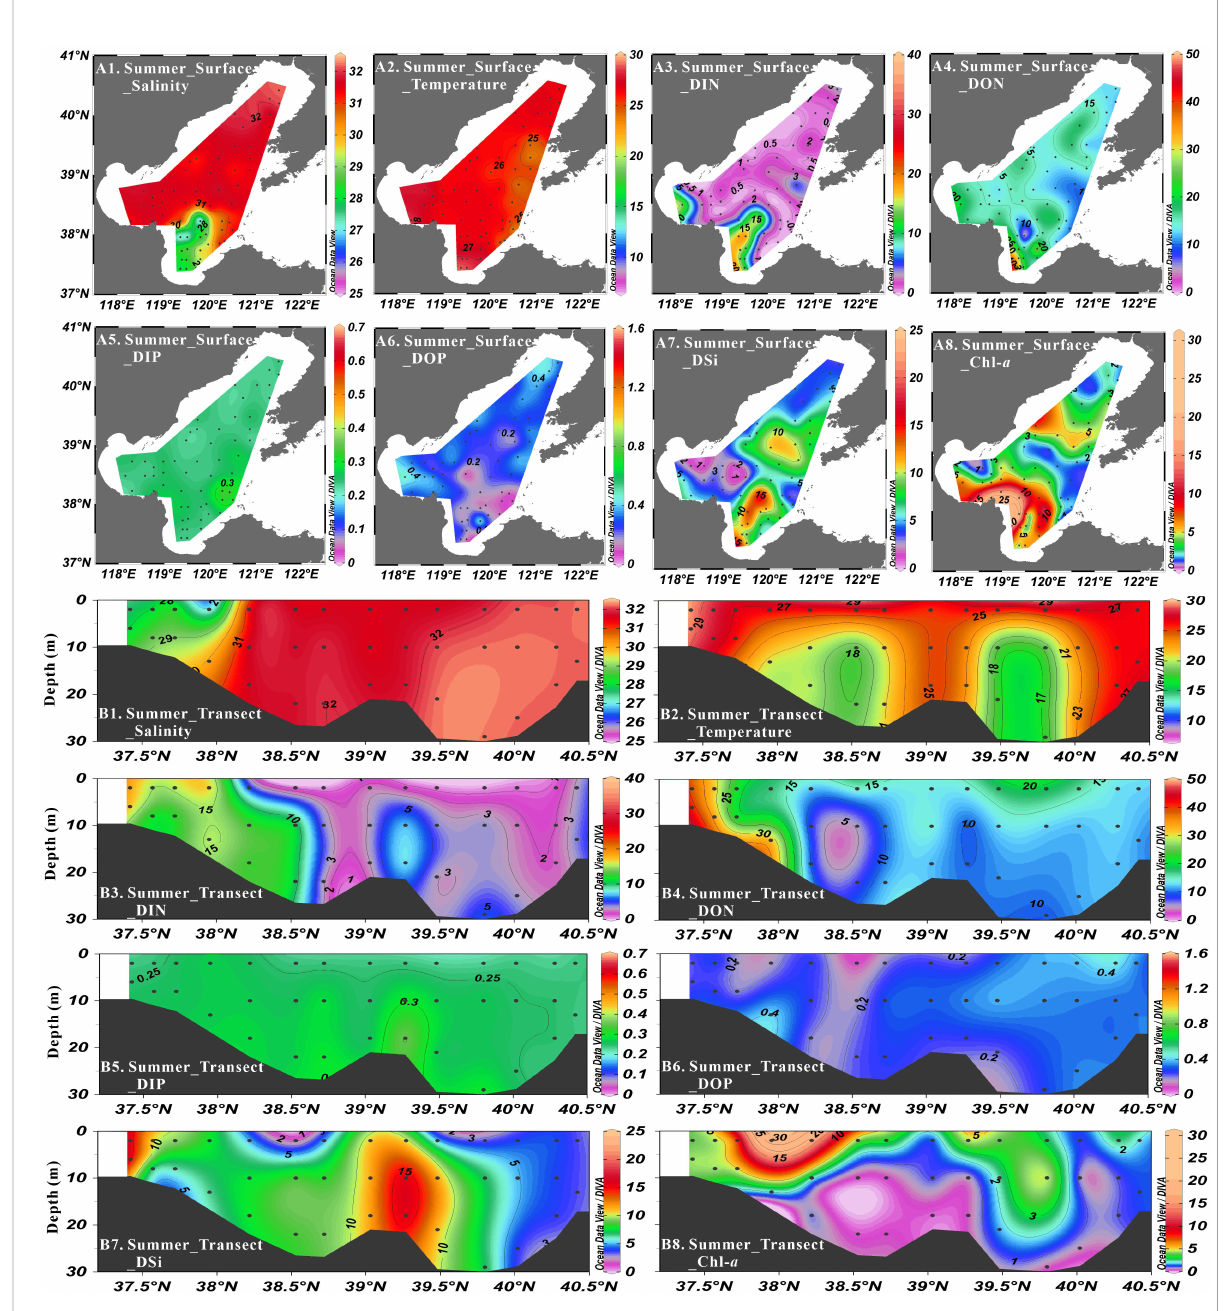
transect (B1-B8) in